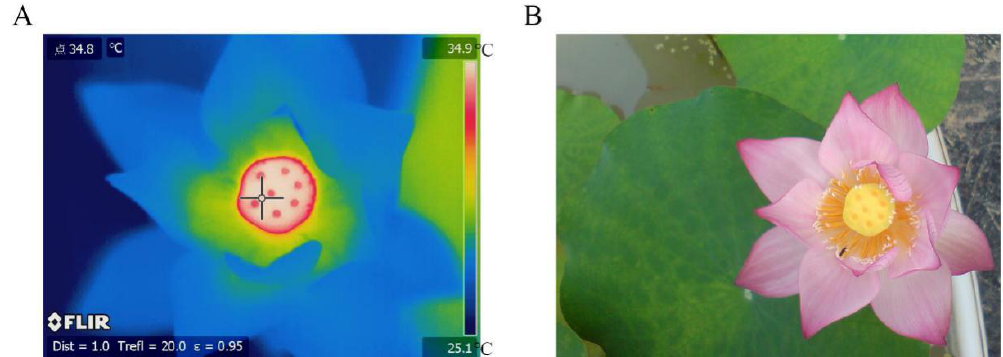
Figure 1. Investigation of floral thermogenesis in N. nucifera . ( A ) An infrared image of N. nucifera in the thermogenic stage. ( B ) An image of N. nucifera in the natural state.